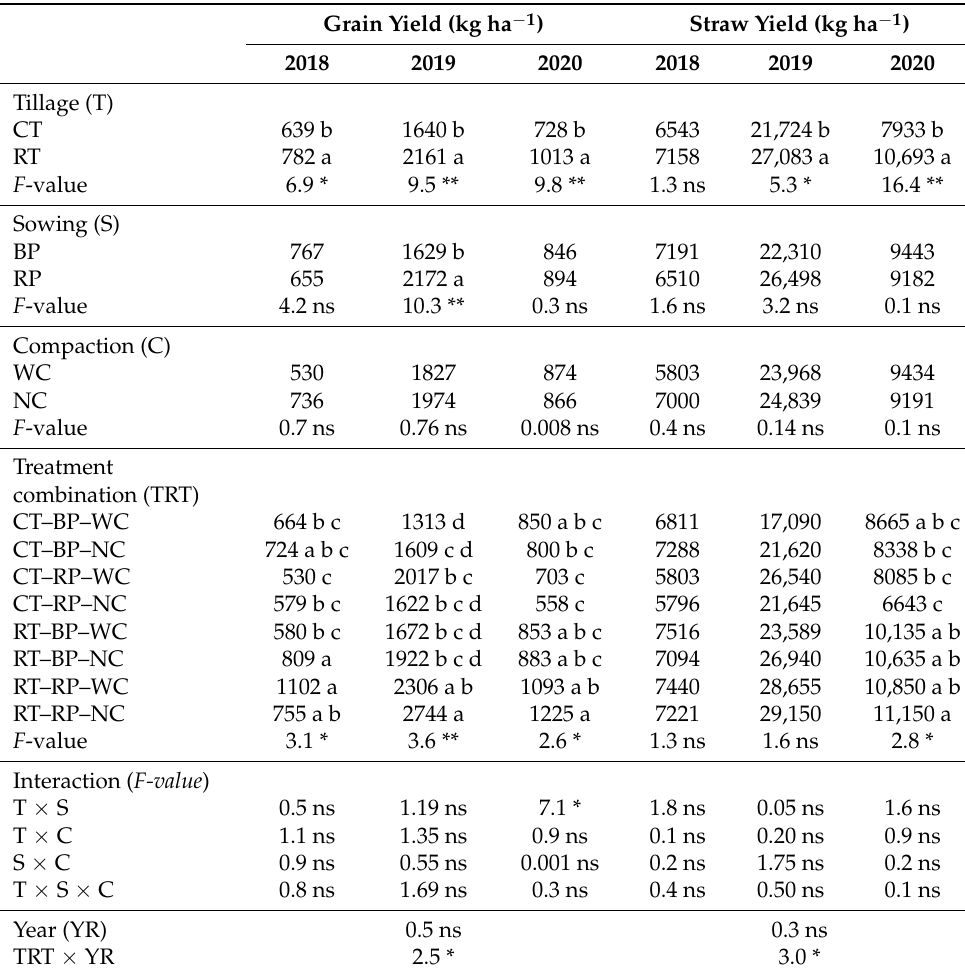
Table 6. Influences of tillage, sowing, and soil compaction methods on grain and straw yields of teff in 2018, 2019, and